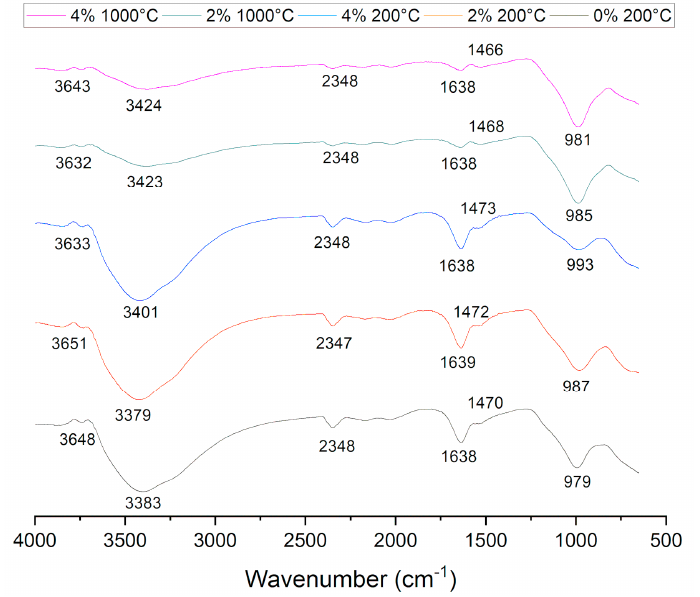
Figure 11. IR spectra of fly ash geopolymers with varying silica fume content addition after being exposed to 200 °C and 1000 °C.